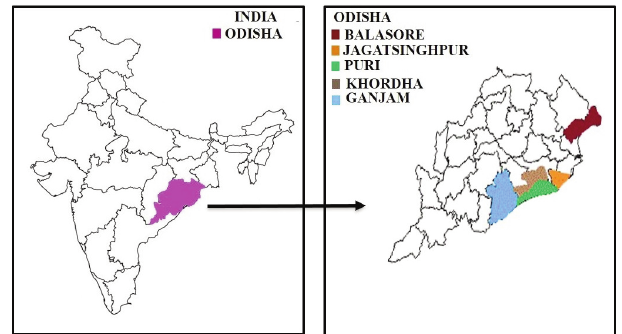
Fig. 2 ­ Map showing the study sites of coastal Odisha (Balasore, Jagatsinghpur, Puri, Khordha and Ganjam